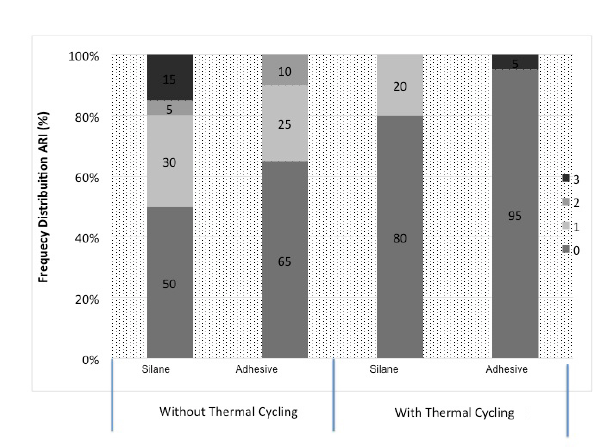
Fig.1. Distribution frequency of Adhesive Remnant Index (ARI)